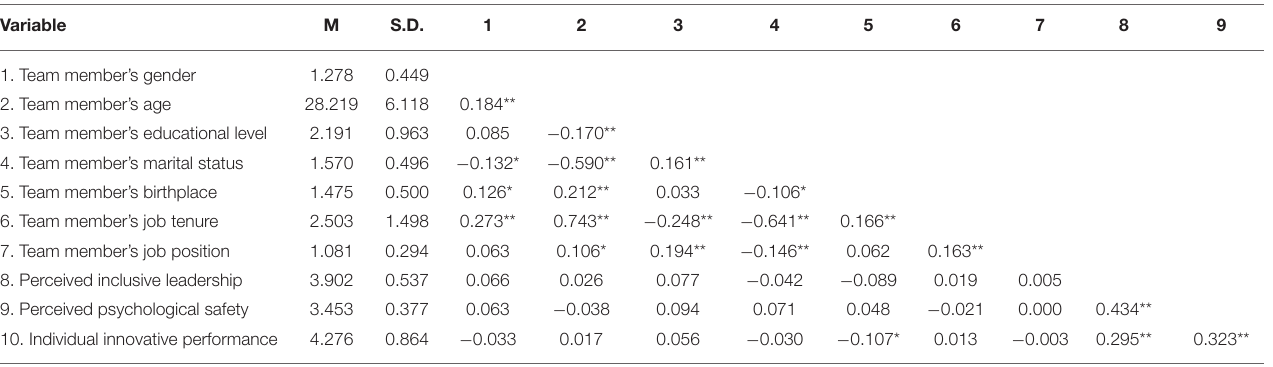
TABLE 3 | Means, standard deviations, and correlations among variables at the individual level. Variable